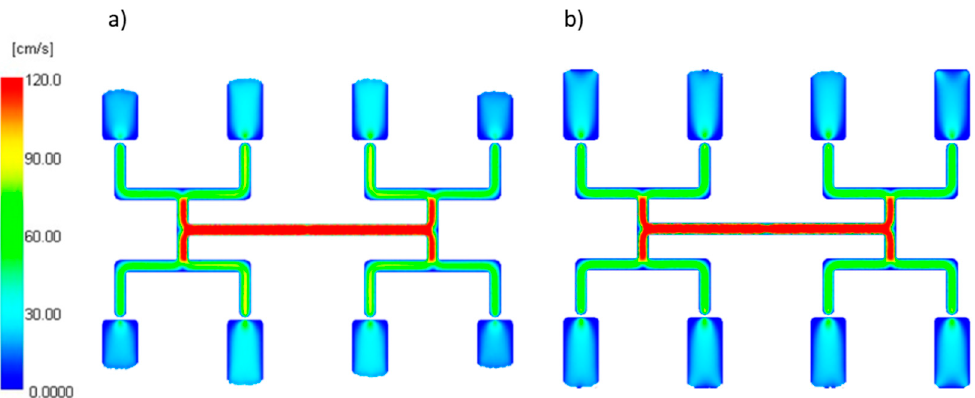
Figure 14. Velocity distribution for different relaxation time at high injection rate: ( a ) λ = 0.001 s, ( b ) λ = 0.1 s.